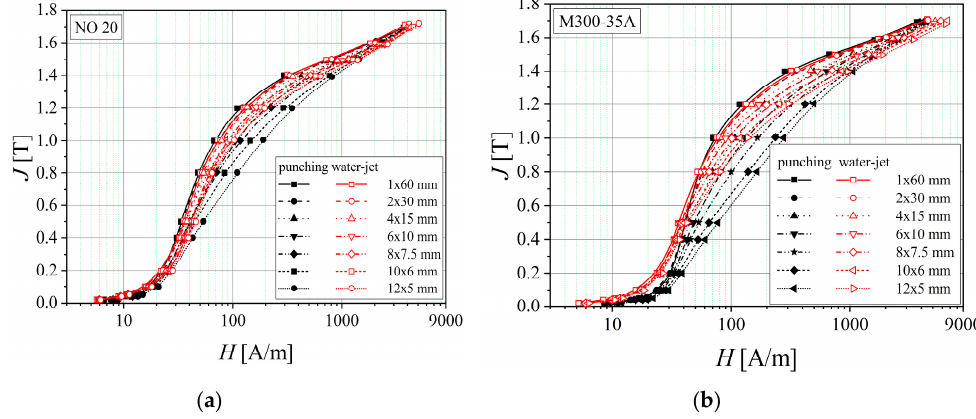
Figure 9. Normal magnetization curves of M400 electrical steel grade, in the case of different sample thickness (0.50 mm ( a ) and 0.65 mm ( b )) and two cutting technologies.